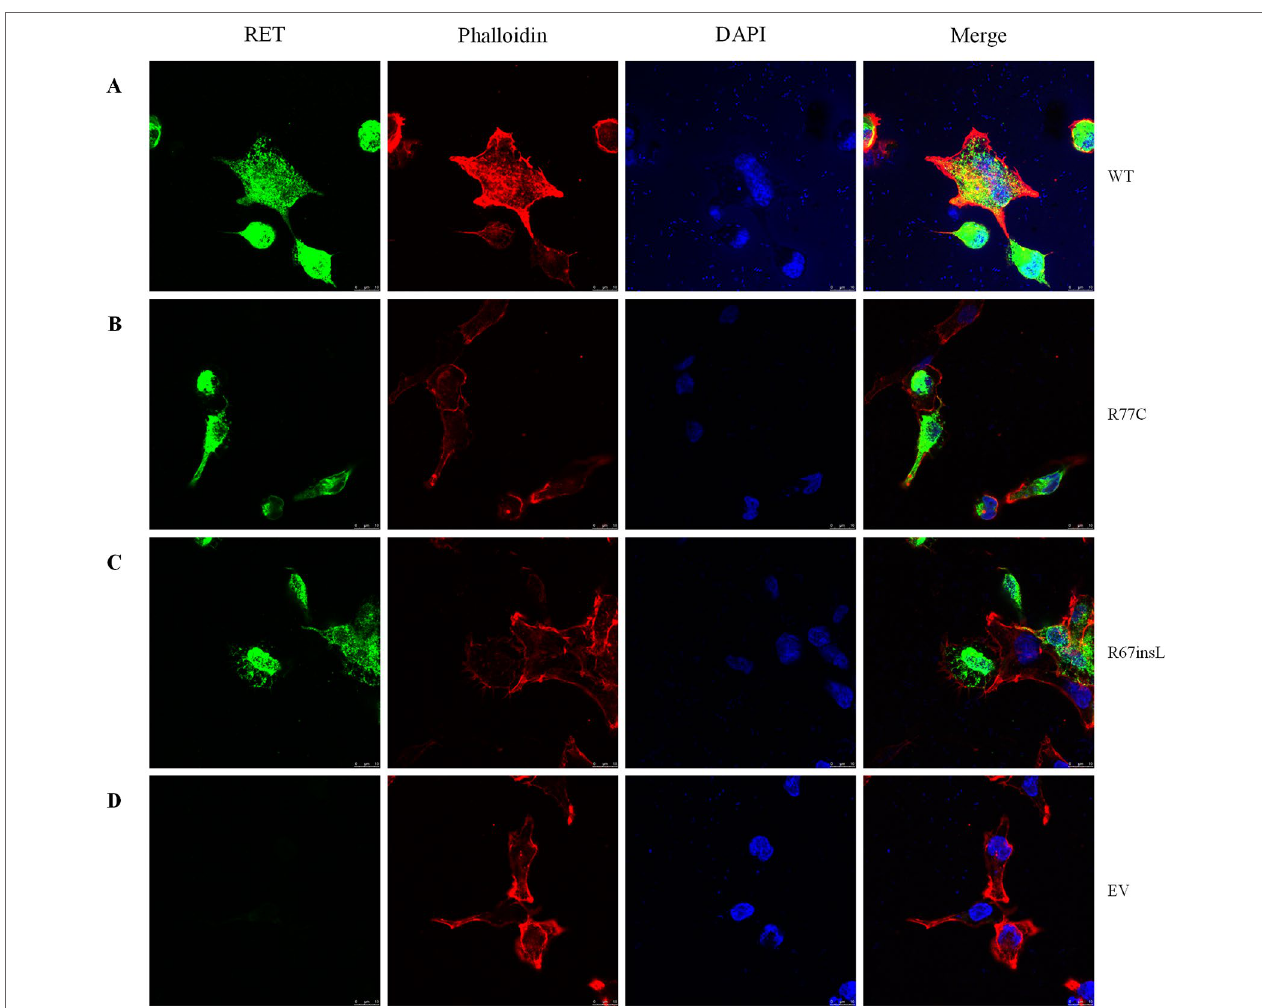
FIGURe 3 | The localizations of RET mutant proteins. Immunofluorescence staining utilizing a primary antibody against RET upon transfection of HEK293 cells with (a) RET-WT, (B) RET-R77C, (C) RET-R67insL, or (D) empty vector (EV). RET-WT staining shows strong signals in both the cytoplasm and cell membrane, whereas the expression of RET-R77C and RET-R67insL is less pronounced on the cell membrane and is localized closer to the nucleolus/endoplasmic